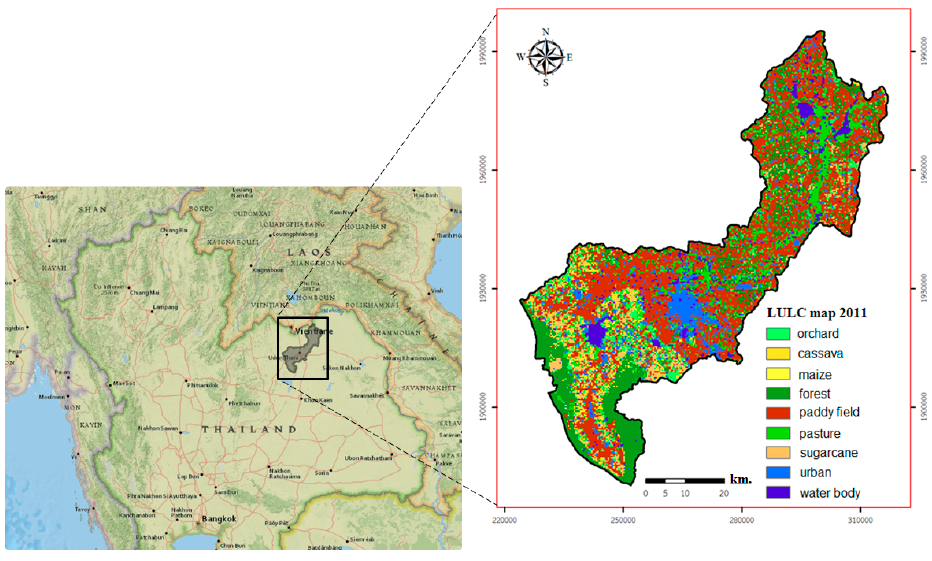
Figure 1. Location of the Huai Luang watershed.